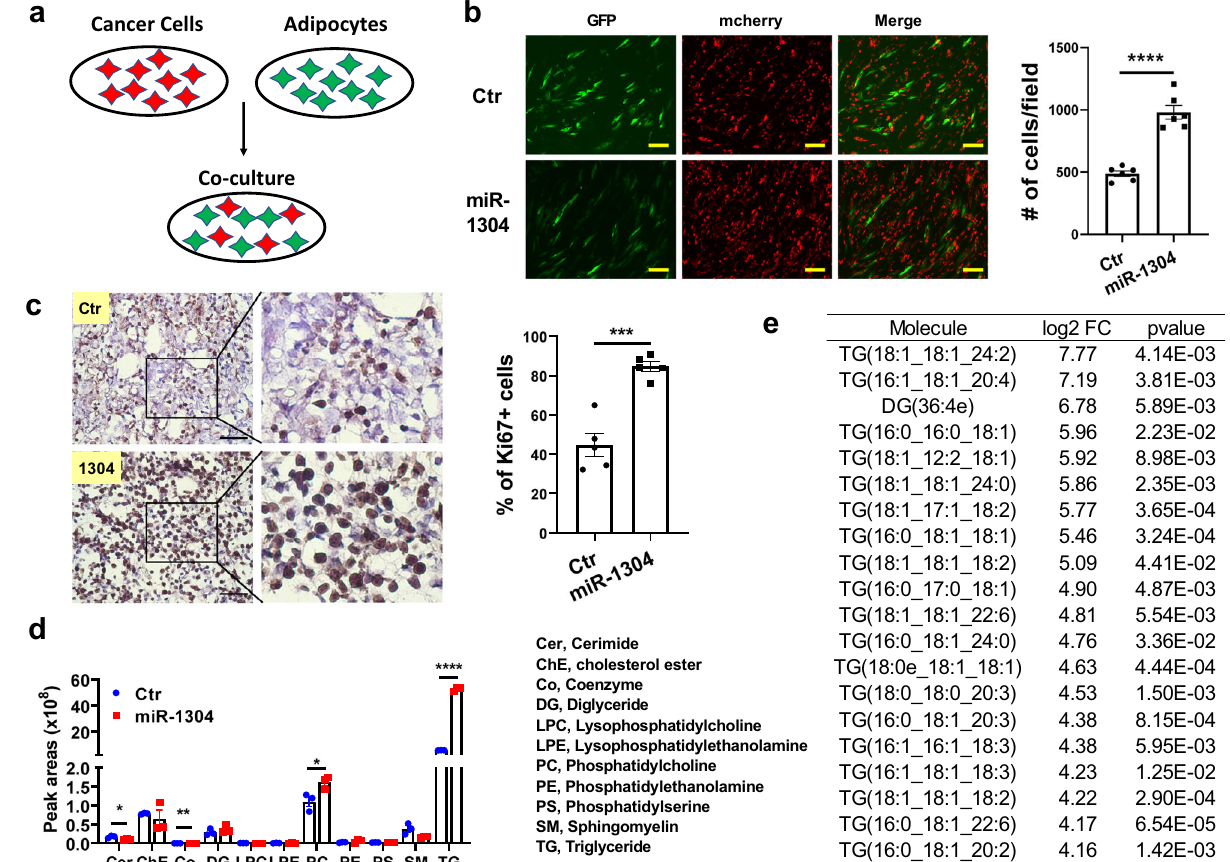
Fig. 4 | miR-1304-3p induced adipocytes promote cancer cell growth. a Cancer cells were labeled with mCherry and adipocytes were labeled with GFP. After dif- ferentiation of adipocytes by adipogenesis inducers including IBMX and rosiglita- zone and changedto serum-free medium, cancercellswereseededdirectlyon top of adipocytes and cultured for 48 hours. b Pictures showing endpoint of cancer- adipocyte co-culture. Number of cancer cells per fi eld ( N = 6 each) was counted with ImageJ. Unpairedtwo-tailedstudentt test, p = 0.000009. Scale bar= 100 μ m. c Tumor xenograft cryosections were stained with Ki67 by IHC, and percentage of Ki67-positivecellswereanalyzed. n =5biologicallyindependentanimals.Unpaired